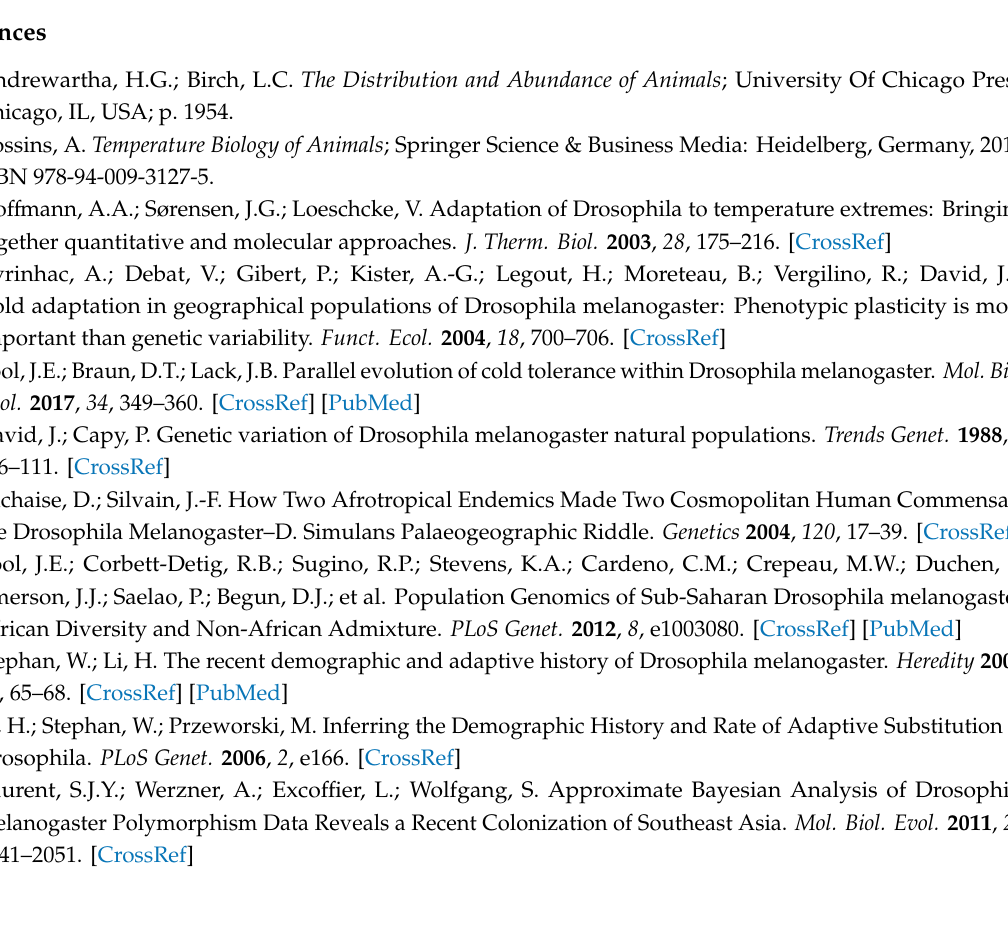
Supplementary Materials: Table S1: Primer sequences, Table S2: Analysis of variance for e ff ects of rearing temperature and climate of origin on vg expression including only temperate populations, Table S3: Fold-changes in gene expression between population samples in adult D. melanogaster , Table S4: Fold-changes in gene expression at di ff erent rearing temperatures between tissues in third instar larvae, Table S5: Fold-changes in tissue-specific gene expression between rearing temperatures in third instar larvae, Table S6: Fold-changes in tissue-specific gene expression between population samples in third instar larvae, Table S7: candidate